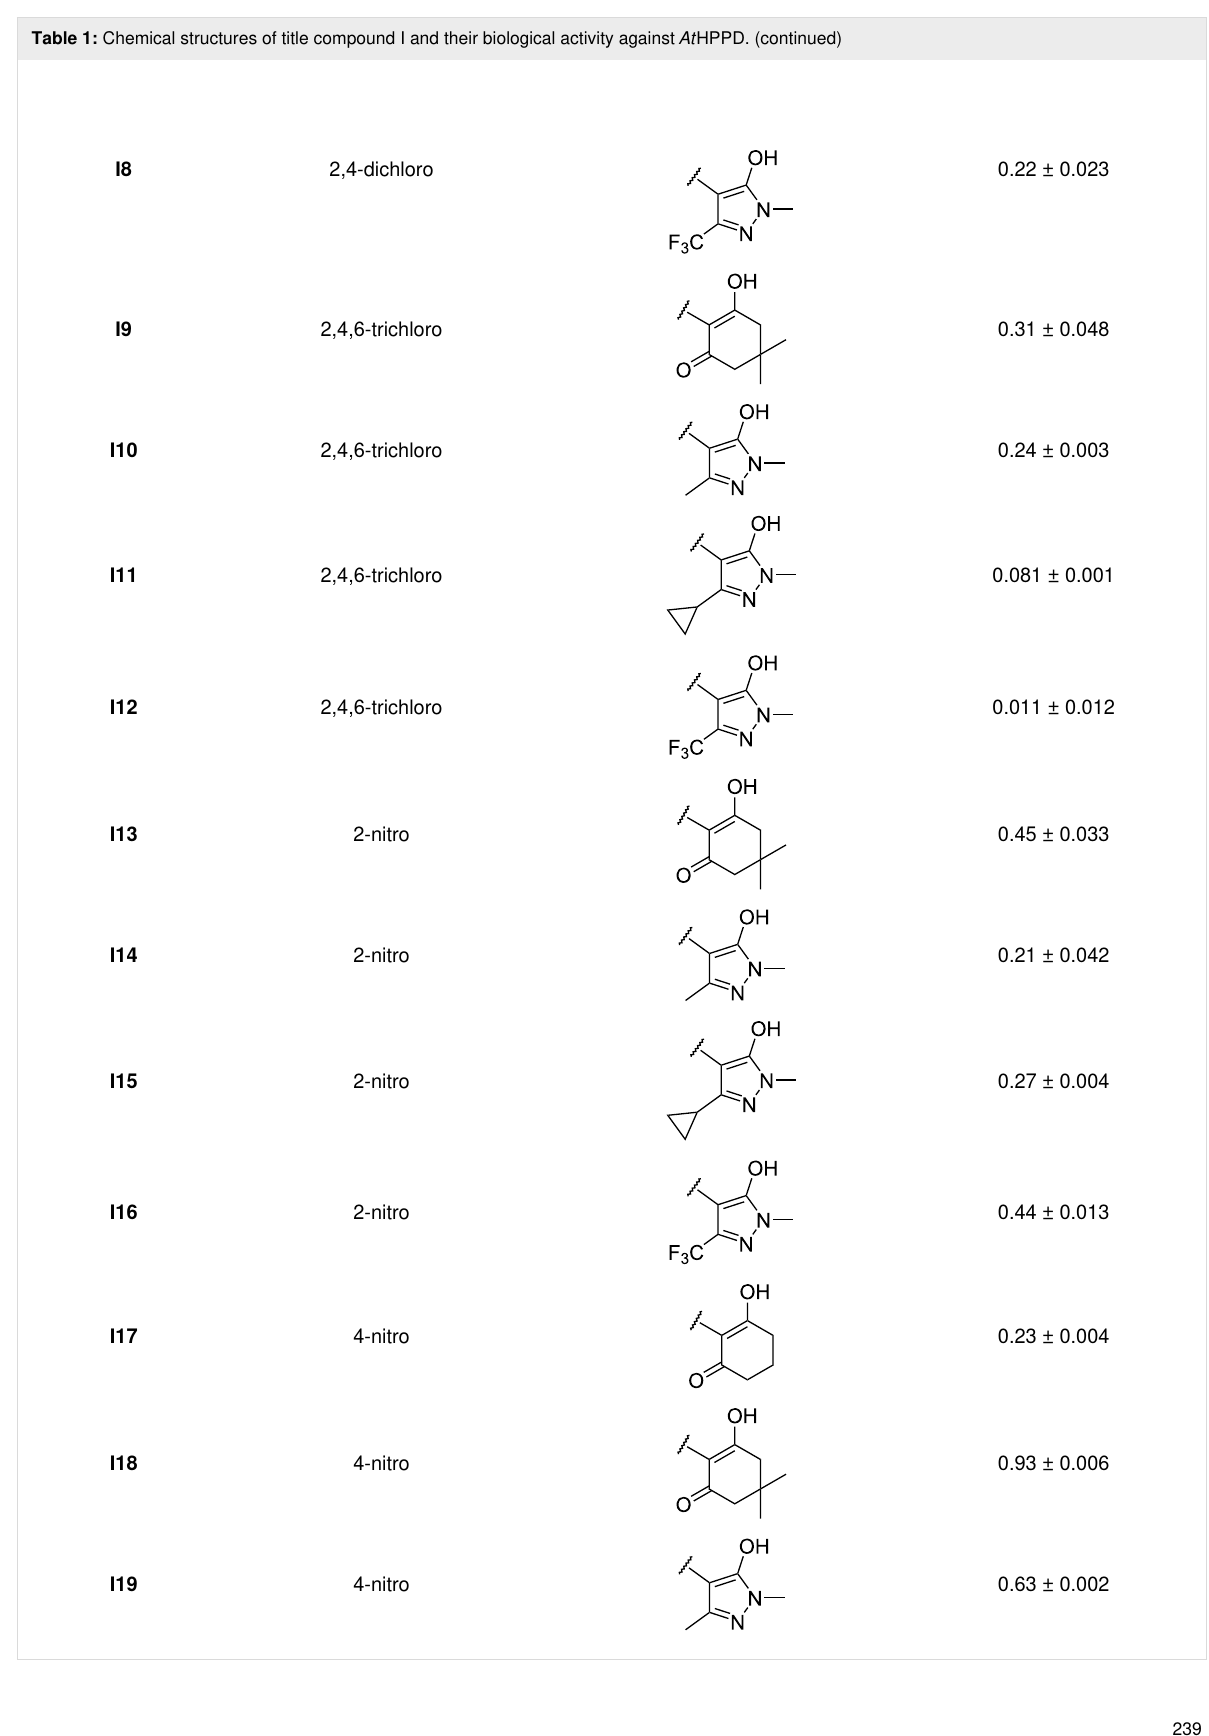
Table 1: Chemical structures of title compound I and their biological activity against At HPPD.